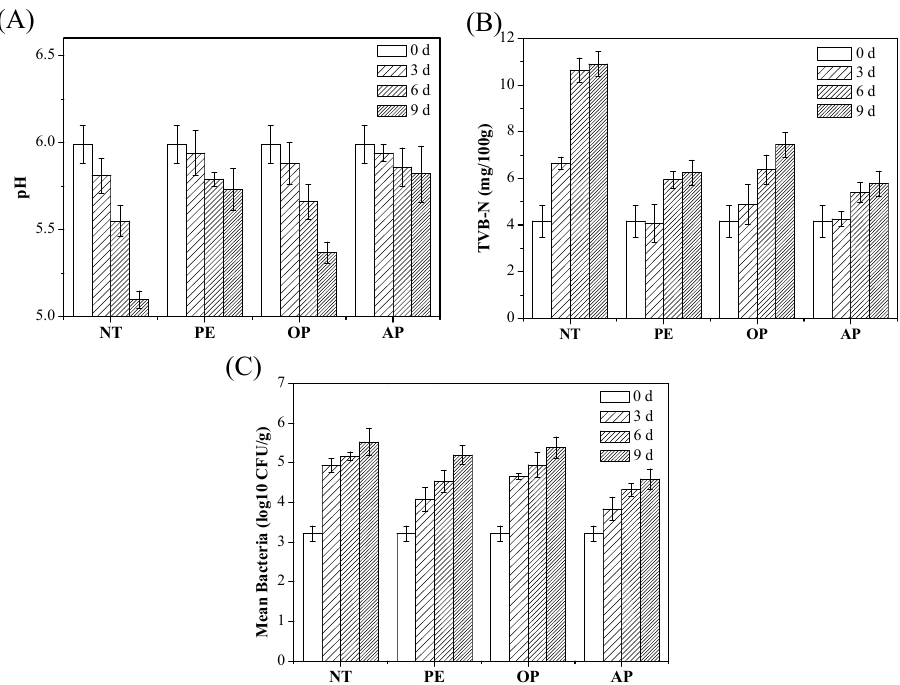
Figure 5. ( A ) pH value; ( B ) total volatile basic nitrogen (TVB-N); and ( C ) total number of bacteria of control group (no treatment, NT), control group (PE film), control group (original paper, OP), and test group (antibacterial paper, AP) in cooked beef during the nine day storage period.